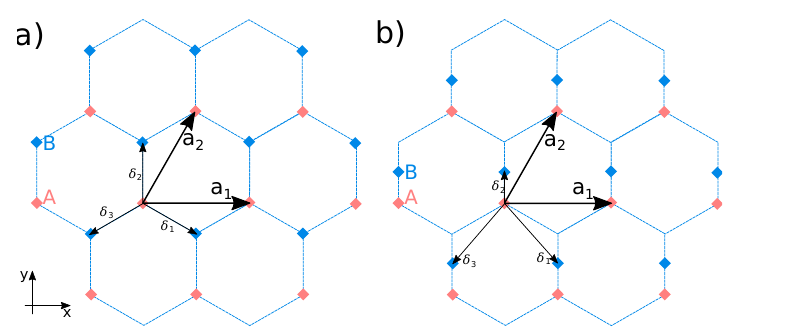
Figure 1. Primitive vectors and atomic basis used in GG (a) and in the related model where one of the sublattices is displaced with respect to the other (b). The B sublattice is δ 2 / 2 . displaced by −